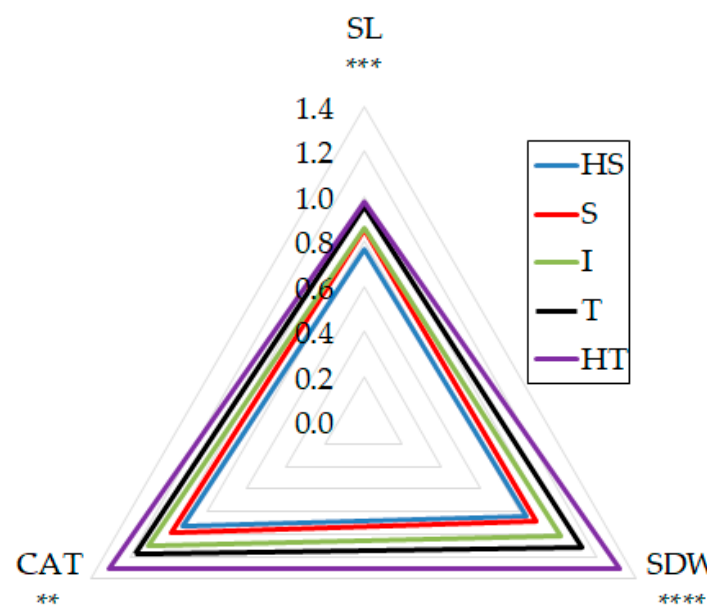
Figure 7. Radar charts comparing three traits of the five groups. Data were analyzed using the Least Squares (LS). **, ***, and **** indicate significance at p < 0.05, 0.001, and 0.0001, respectively. Shoot length (SL), catalase (CAT), shoot dry weight (RDW), highly tolerant (HT), tolerant (T), intermediate (I), sensitive (S), and highly sensitive (HS).